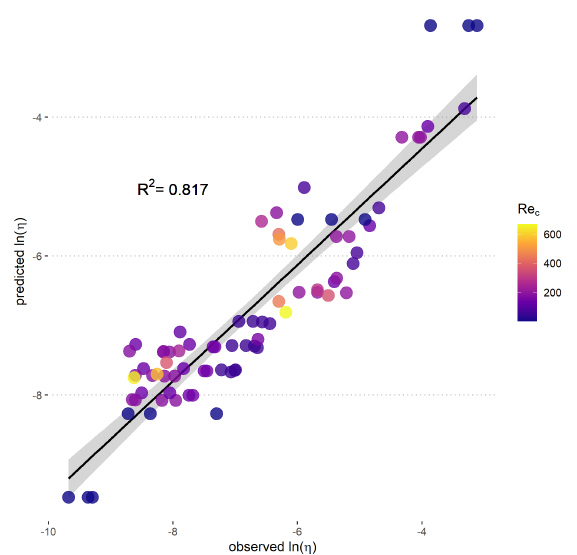
Figure 2. Observed ln( η ) for all data points ( n = 80) compared with ln( η ) predicted by Equation (8). Data points are colored by collector Reynolds